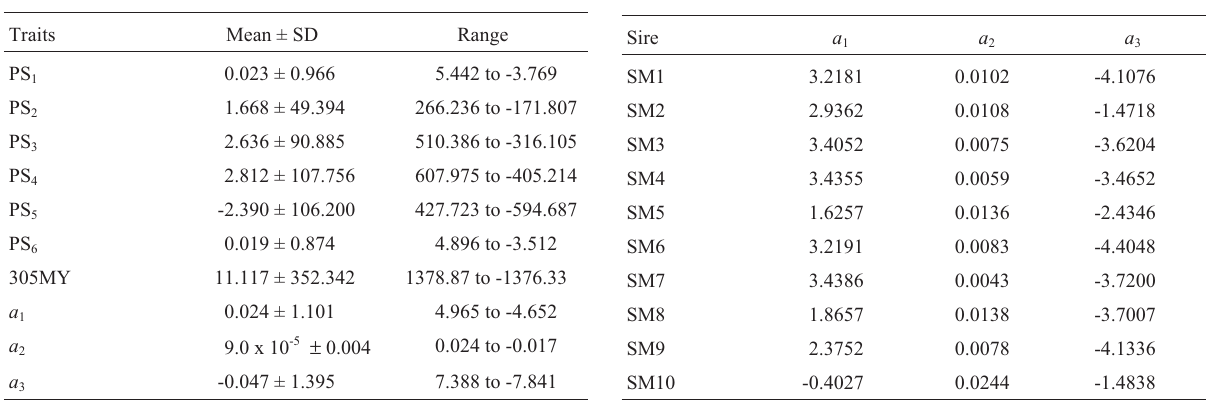
Table 2 - Estimates of the genetic random regression coefficients ( a 1 , a 2 and a 3 ) of the Wilmink function for the top ten sires with more than 25 daughters ranked for milk